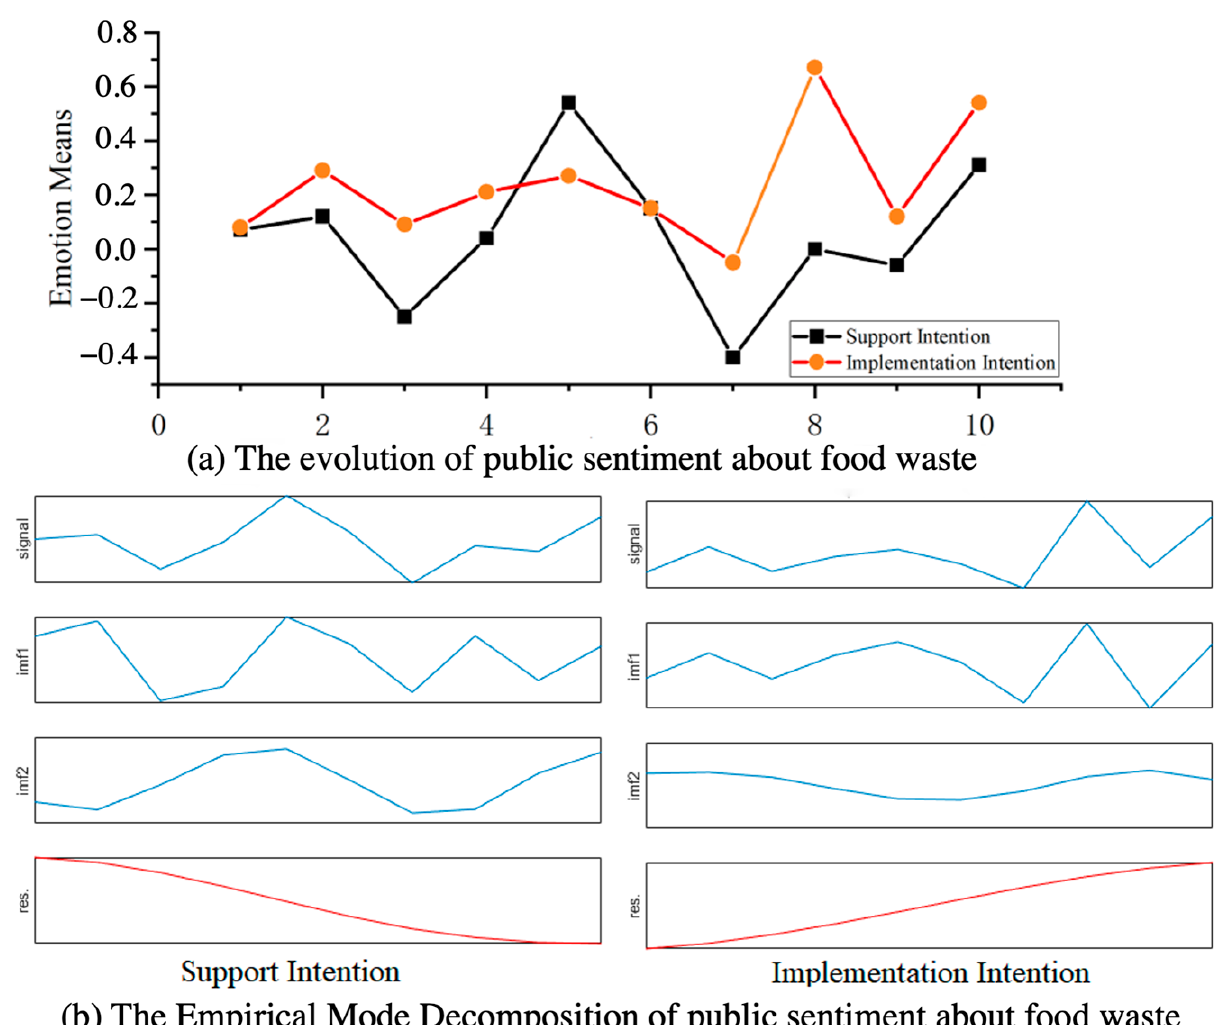
Figure 3. The evolution of public sentiment about food waste ( a ) and the EMD figure ( b ).